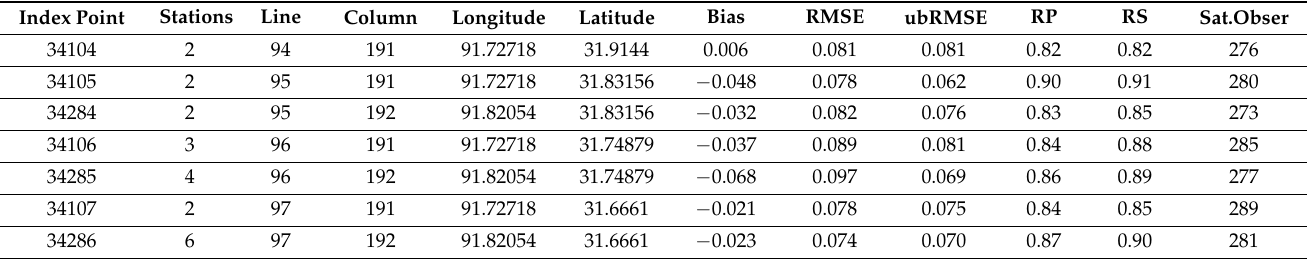
Table 3. Comparisons and validation measures for Satellite (SPL3SMP_9km) and observed SSM in the Naqu network, including all the datasets from 1 April 2015 to September 2016. Units are in m 3 /m 3